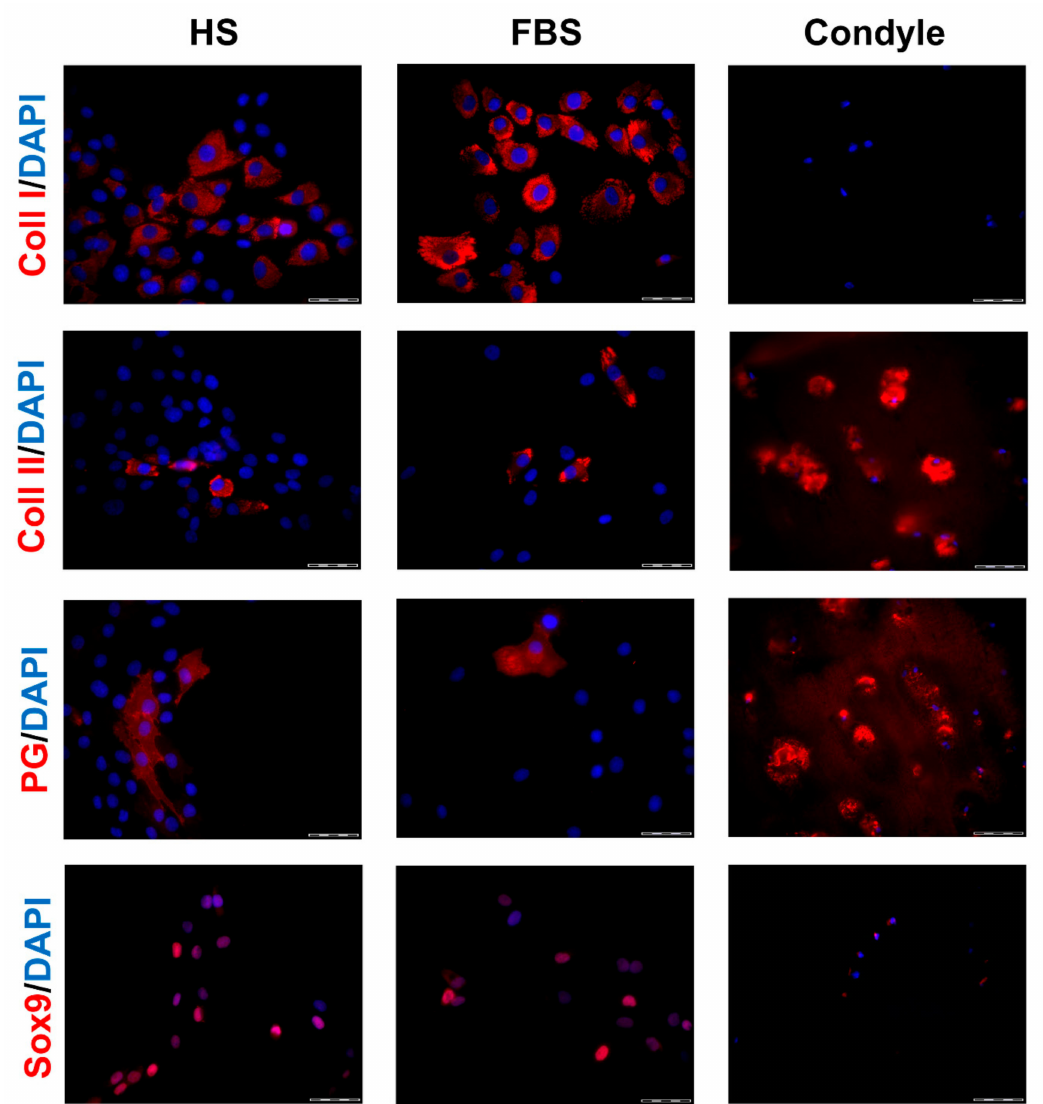
Figure 3. Expression of cartilage-specific markers in 2-dimensional (2D) chondrocytes of a representative donor. Immunocytochemical analyses on P2 chondrocytes cultivated with medium containing either HS or FBS. Sections from the condyle of the same donor is shown as reference. Red: Collagen type I (Coll I), collagen type II (Coll II), proteoglycans (PG), and Sox9, respectively. Blue: Cell nuclei. Scale bars: 50 µ